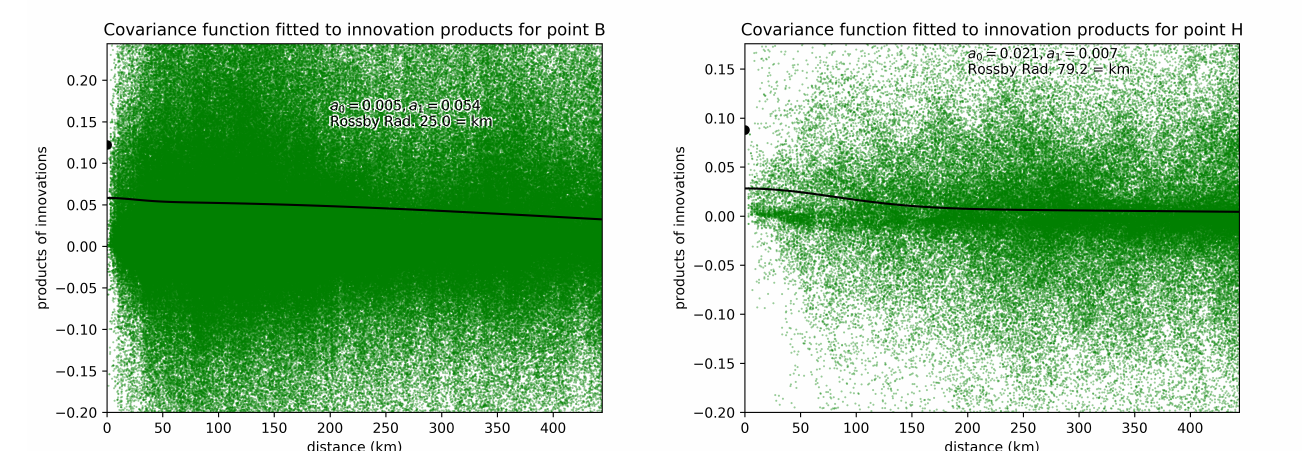
2 / 2 / 2 [ Lr ( r 0 )] 2 + a 1 e (cid:107) r − r 0 (cid:107) 2 L 2 fitted to all pairs of innovation